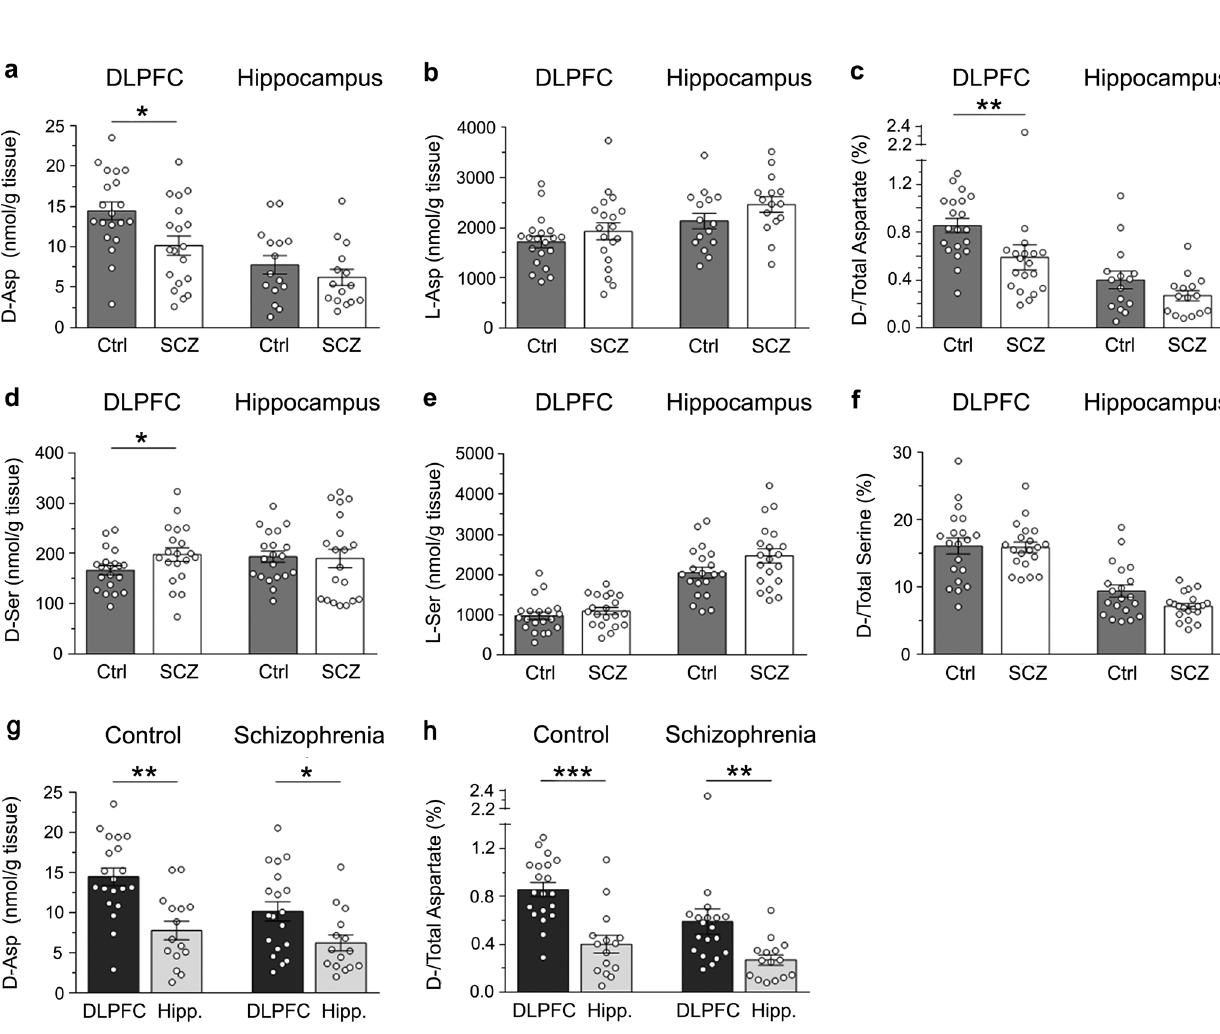
Fig. 1 Age-related changes in D -aspartate and D -serine levels between patients with schizophrenia and control subjects in the post-mortem dorsolateral prefrontal cortex and hippocampus. a Representative images of the dorsolateral prefrontal cortex ( DLPFC ) and hippocampus dissected from post-mortem brains of healthy (control, Ctrl) and schizophrenia-affected individuals ( SCZ ). The dot plots represent the variations across lifespan in the content of free b , h D -aspartate and e , k D -serine, c , i L -aspartate and f , l L -serine, and d , g , j , m D -/total amino acids in the b – g dorsolateral prefrontal cortex ( DLPFC ) and h – m hippocampus of non-psychiatric individuals (DLPCF, n = 20; hippocampus, n = 15) and patients with schizophrenia (DLPCF, n = 19; hippocampus, n = 15). In each sample, all the amino acids were detected in a single run by HPLC and expressed as nmol/g of tissue, while the ratios are expressed as percentage (%)